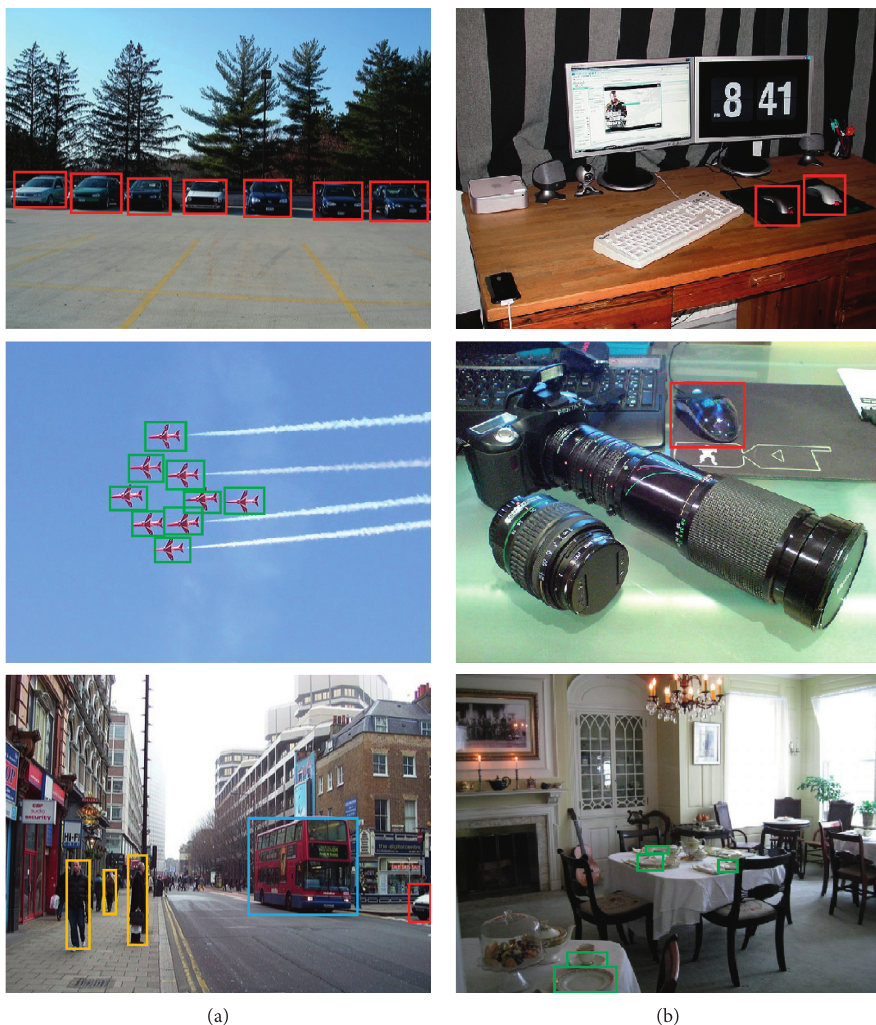
Figure 1: Illustration of (a) objects such as a bus, plains, or cars that have big appearance but occupy small parts on an image taken from [11] and (b) objects that really own small appearance such as mouses or plates taken from